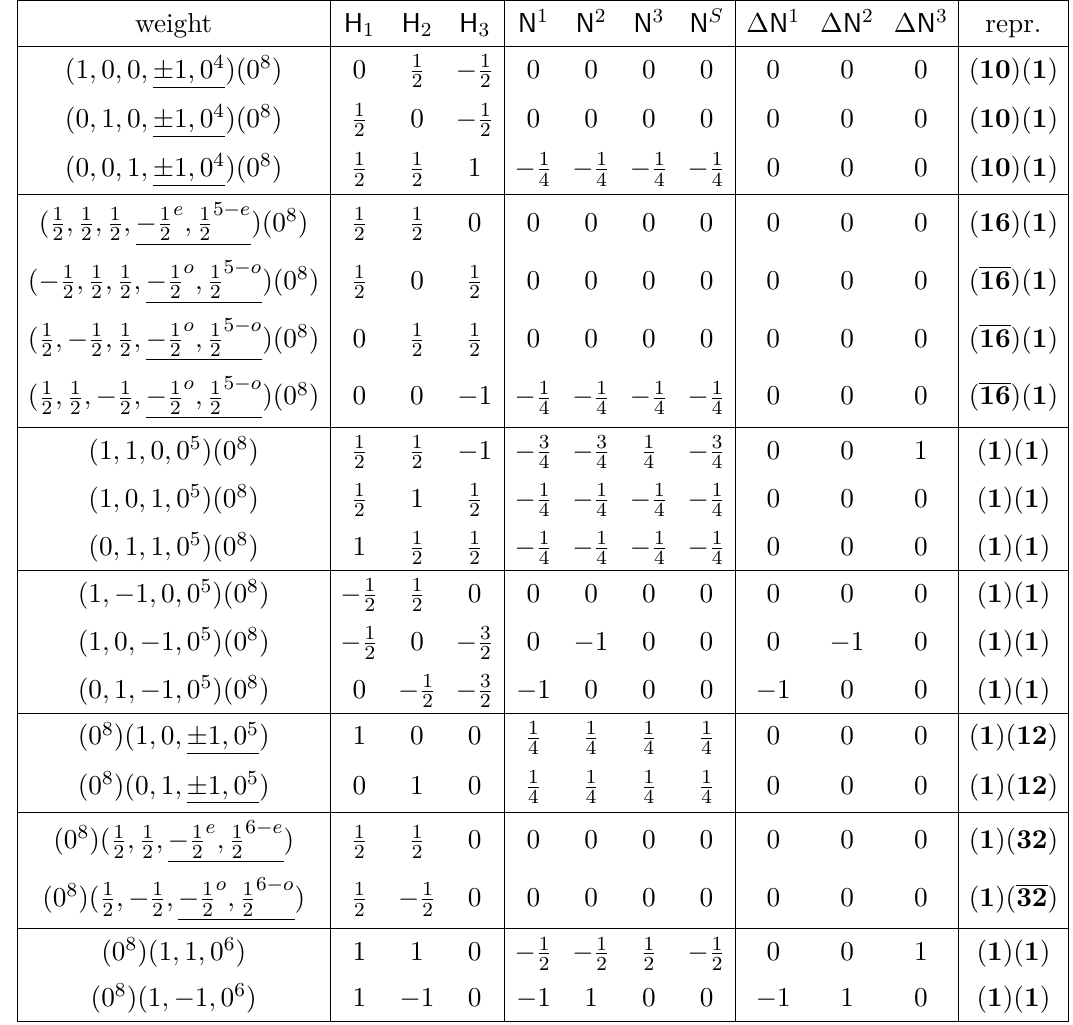
Table 5 . The line bundle charges H i , the triangulation multiplicities N i , N S and the difference multiplicities ∆ N i are given for all the E 8 × E 8 roots charged under the line bundle background defined by (4.12). The underline of some of the entries in these roots denote all possible permutations of them. Notice, that these difference multiplicities, that measure jumps in the spectrum when going through a flop-transition, are always